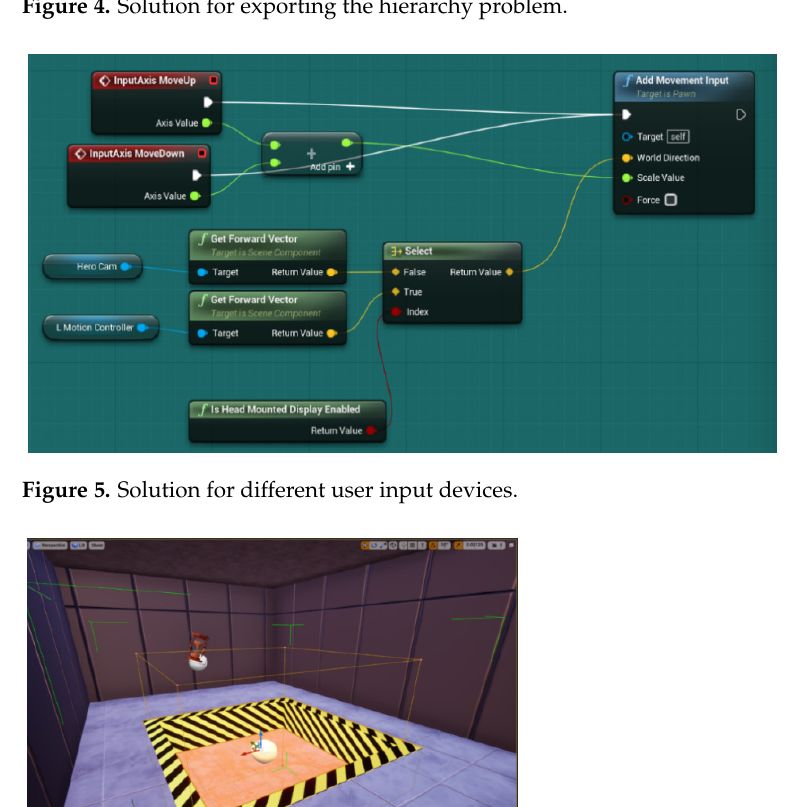
Figure 5. Solution for different user input devices. Figure 6. Example of the pitfall trap solution.